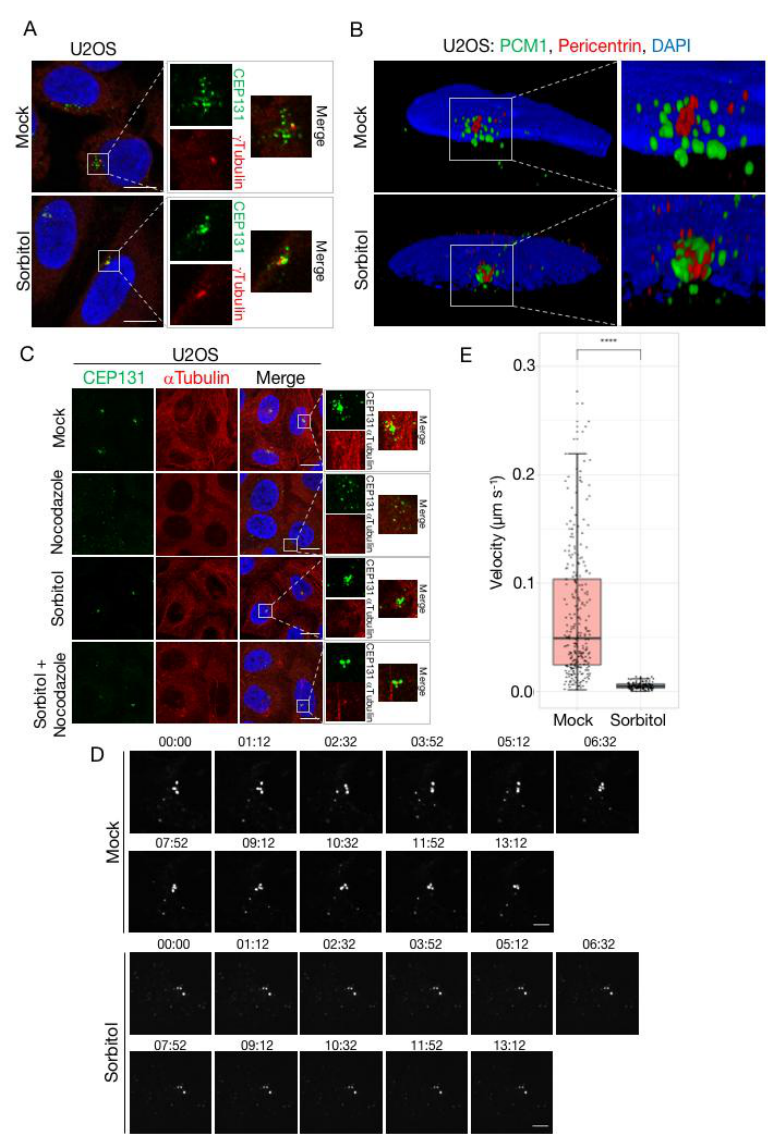
Figure 5. Dispersal and mobility of centriolar satellites is impaired by sorbitol. ( A ) U2OS cells were left untreated (mock) or incubated in the presence of sorbitol (1 h). Cells were immunostained with antibodies against CEP131 and γ -tubulin, counterstained for nuclear content with DAPI, and subjected to confocal microscopy. Scale bars, 10 µ m. ( B ) Cells from ( A ) were immunostained with antibodies against PCM1 and pericentrin, counterstained for nuclear content with DAPI, and subjected to 3D-SIM microscopy. Pictures represent reconstructed images shown as 3D projections. ( C ) U2OS cells were pre-treated with sorbitol (1 h) and incubated in the presence of nocodazole (3 h) as indicated. Cells were immunostained with antibodies against CEP131 and α -tubulin and counterstained for nuclear content with DAPI. Scale bars, 10 µ m. ( D ) U2OS cells stably expressing low levels of GFP-CEP131 were incubated in the presence or absence of sorbitol and subjected to time-lapse microscopy. Note the high mobility of satellites in mock-treated cells compared to their near-complete immobility in sorbitol-treated cells (see also Supplementary movies 1 and 2). Scale bars, 5 µ m. ( E ) Quantification of satellite velocities from ( D ). Trajectories of individual satellites were identified using the MOSAIC ImageJ/Fiji plug-in. Trajectories from three independent movie streams were used to calculate velocities of individual satellites. The two groups were compared using Wilcoxon rank sum test with continuity correction. p < 2.2 × 10 − 16 . (see also Supplementary movies 3 and